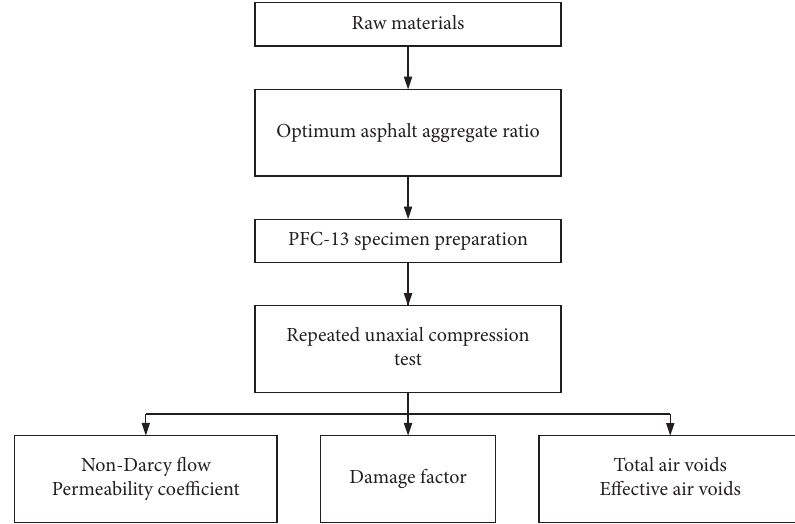
Figure 1: Flowchart of study materials and corresponding test